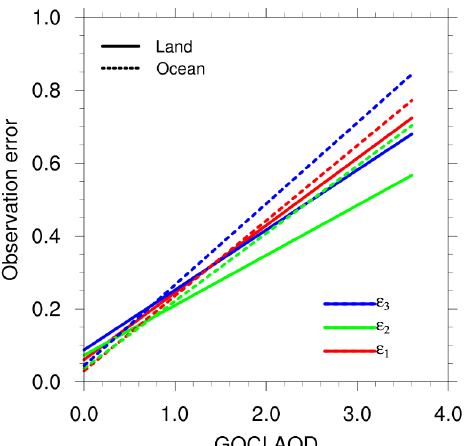
Figure 4. Three different types of observation errors ( (cid:15) ) applied to GOCI AOD retrievals over land (solid line) and ocean (dashed line). The first two errors ( (cid:15) 1 and (cid:15) 2 ) are described in Eqs. (3)–(6), and the third error ( (cid:15) 3 ) increases (cid:15) 2 by 20%